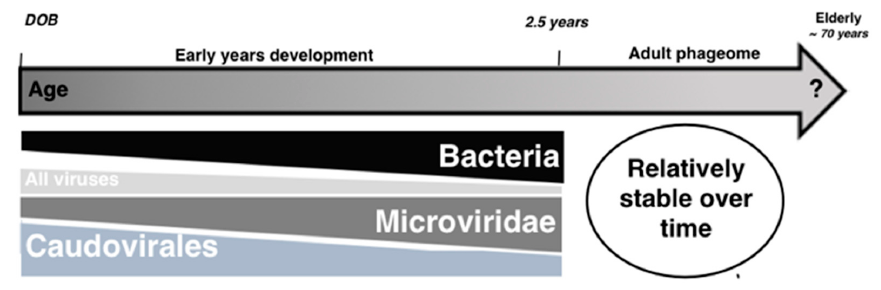
Figure 2. Schematic representation of the gut phage community development with age. Individuals are colonized early after birth, within 0–4 days after birth (DOB). During the first days of life, the diversity of the phage community is high and the microbial community abundance and diversity is low [51]. A reduction in Caudovirales diversity leads to an expansion and a shift in the microbial community composition and an increase in Microviridae phage diversity and abundance. A relatively stable phage community is maintained during the adult life. Changes in the phage community associated with a shift towards an elderly ‐ like microbial community are unknown.